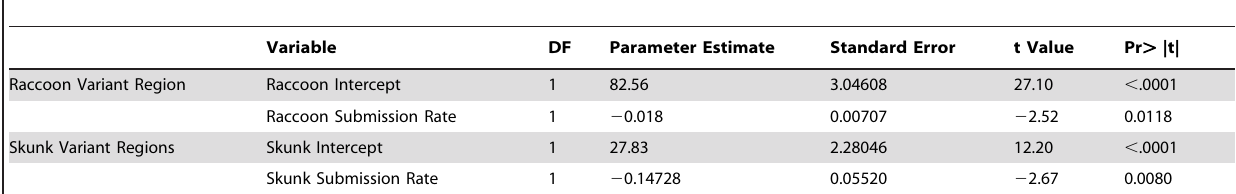
Table 3. Linear Regression of Reservoir Submission Rate and Cross Species Transmission Rate: Skunk and Raccoon Variant Regions,